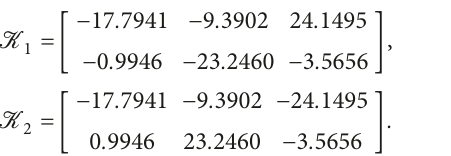
Figure 7: State trajectory of the fuzzy chaotic system (72) with control input.